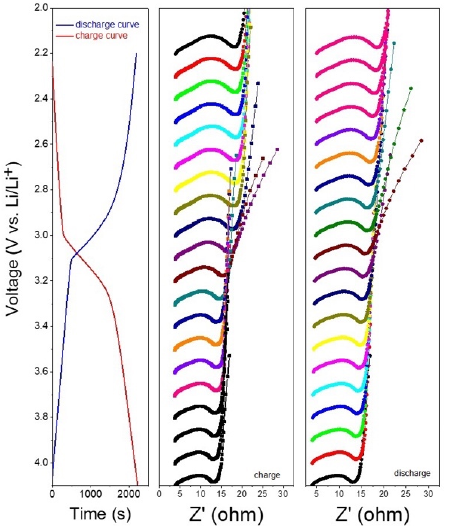
Figure 2. Electrochemical impedance spectroscopy of HyLICs.